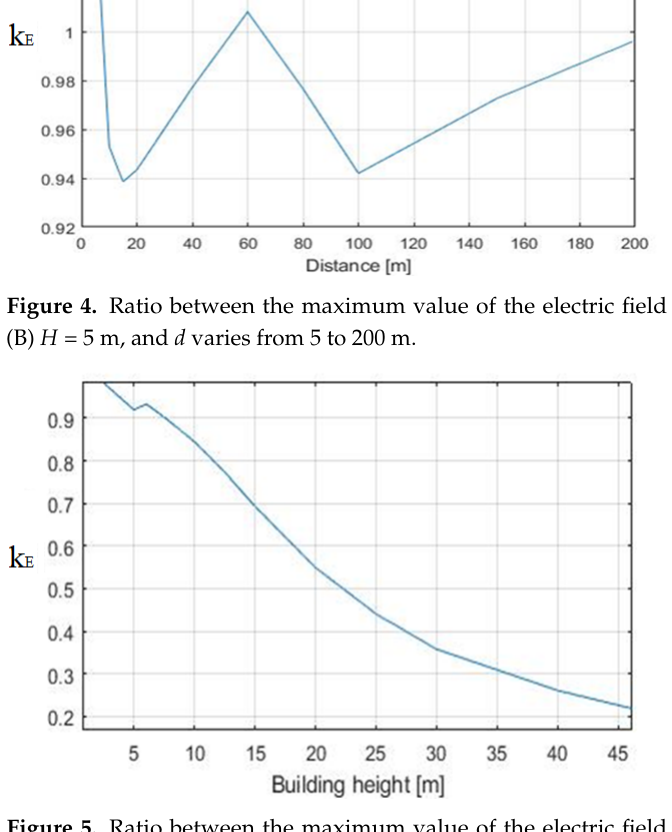
Figure 5. Ratio between the maximum value of the electric field with and without the building. (C) d = 10 m, and H varies from 5 to 50